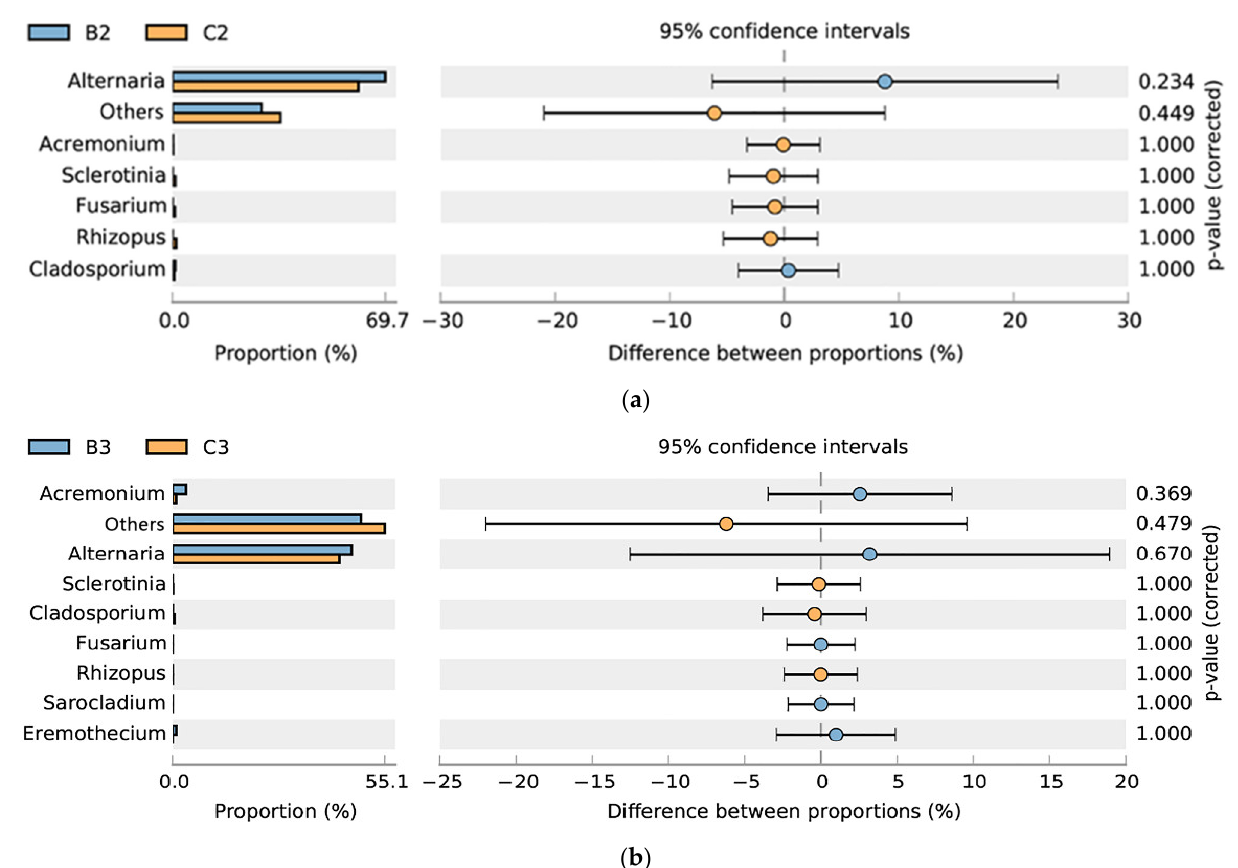
Figure 8. STAMP analysis of internally mildewed fungus–seed symbiosis. B, post-storage seeds. C, post-harvest seeds. ( a ) B2, B3, post-storage seeds (2019–2020); ( b ) C2, C3, post-harvest seeds